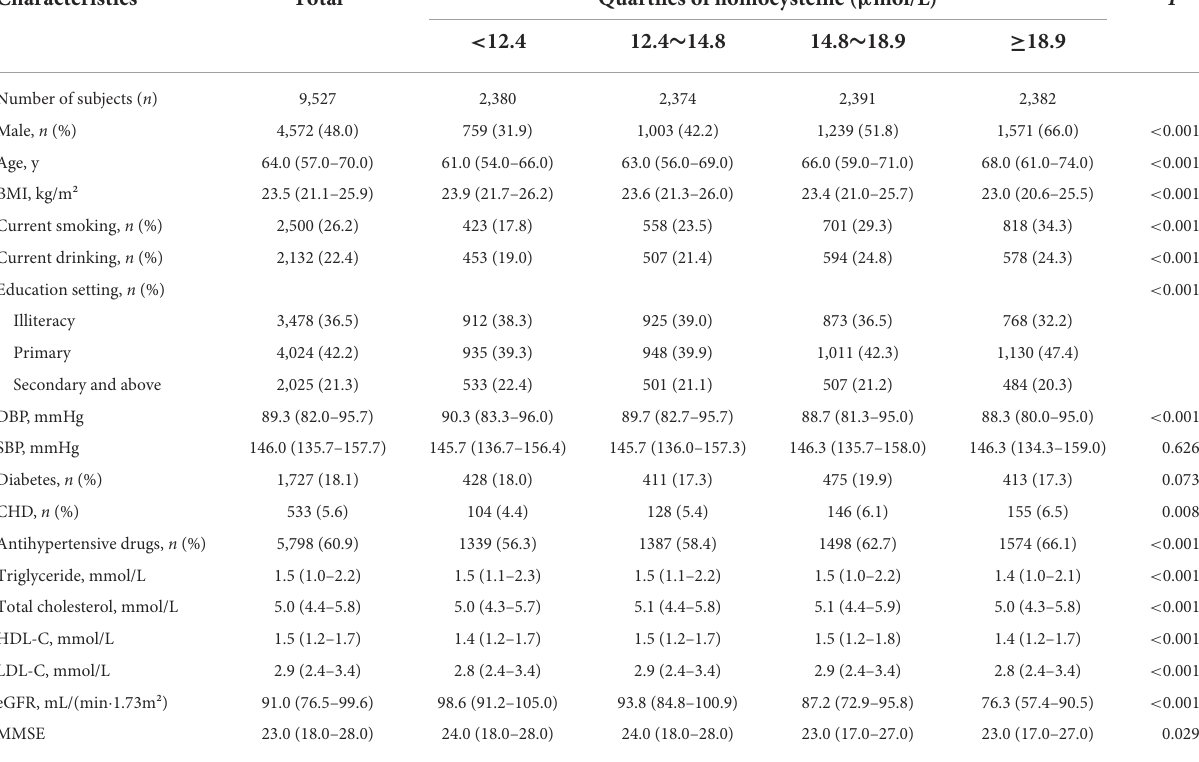
TABLE 1 Baseline characteristics of the study population according to quartiles of homocysteine.